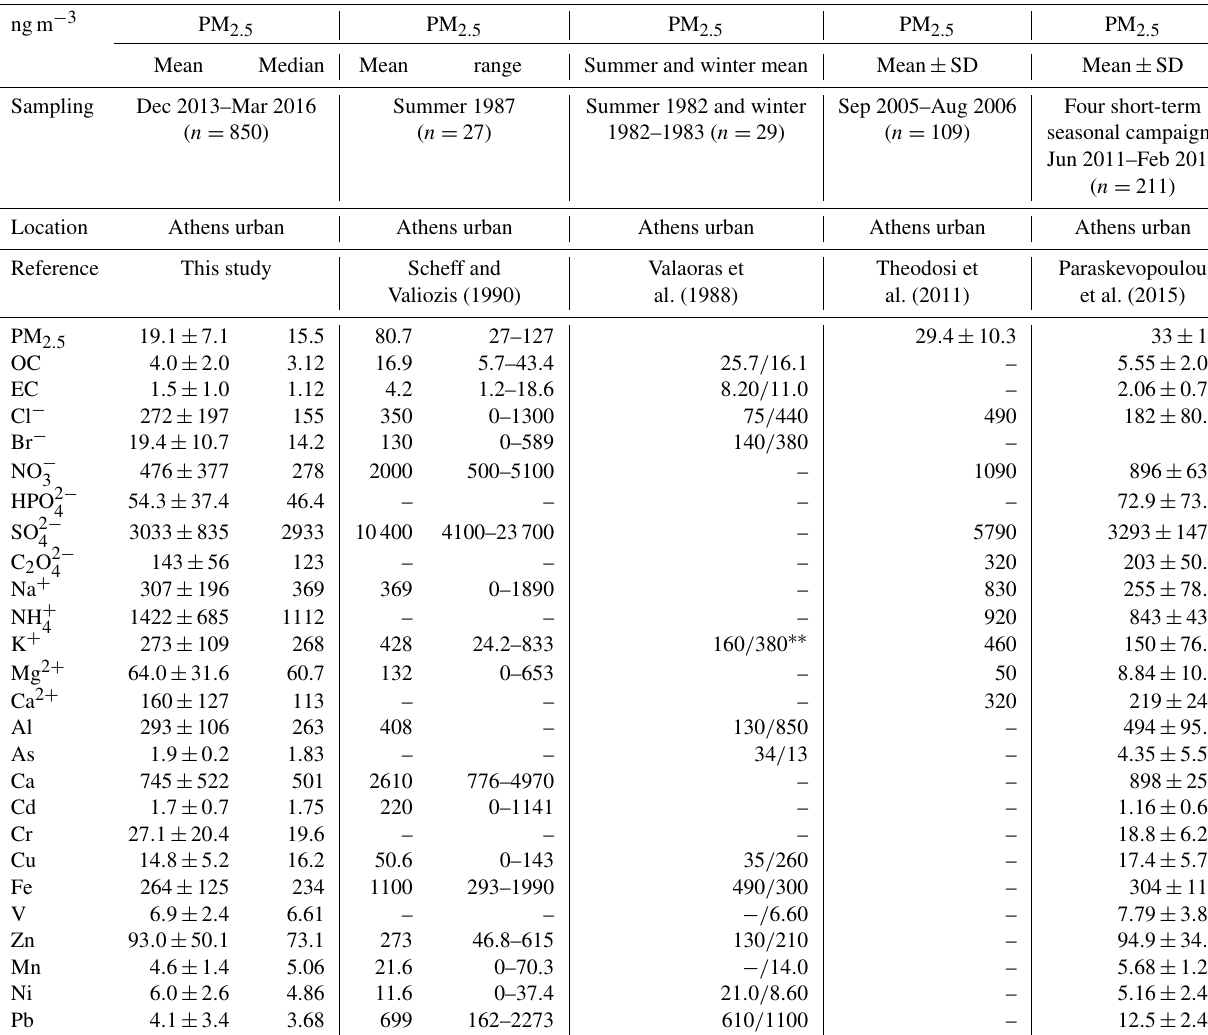
Table 1. Mean, standard deviation, median, and range of measured concentrations for PM 2 . 5 aerosol samples, collected at Thissio and other urban sites in Athens. Values for PM 2 , 5 , OC, and EC are in µgm − 3 , whereas for the rest of the species, they are in ngm − 3 .